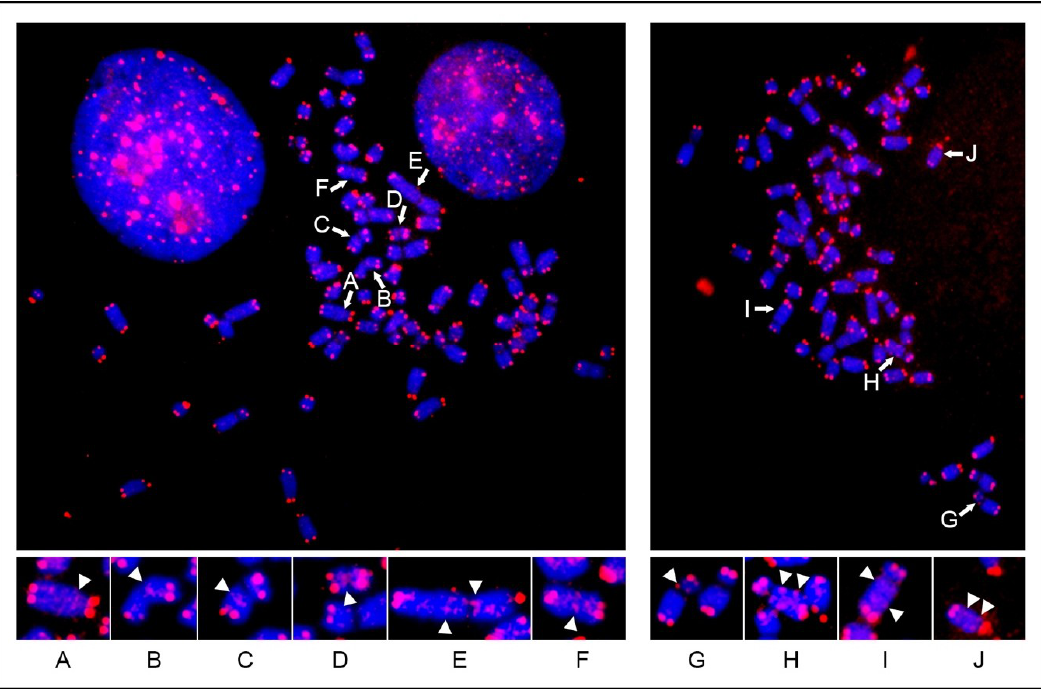
Figure 1. Fluorescence in situ hybridization with telomeric probe on two metaphase spreads from horse primary fibroblasts. Chromosomes are labelled with DAPI. Hybridization signals (red) at chromosome ends mark telomeres. Some of the chromosomes showing faint hybridization signals corresponding to short interstitial telomeric sequences are indicated (white arrows). Magnifications of selected chromosomes are reported below each metaphase, and some of the interstitial telomeric signals are marked by arrowheads.